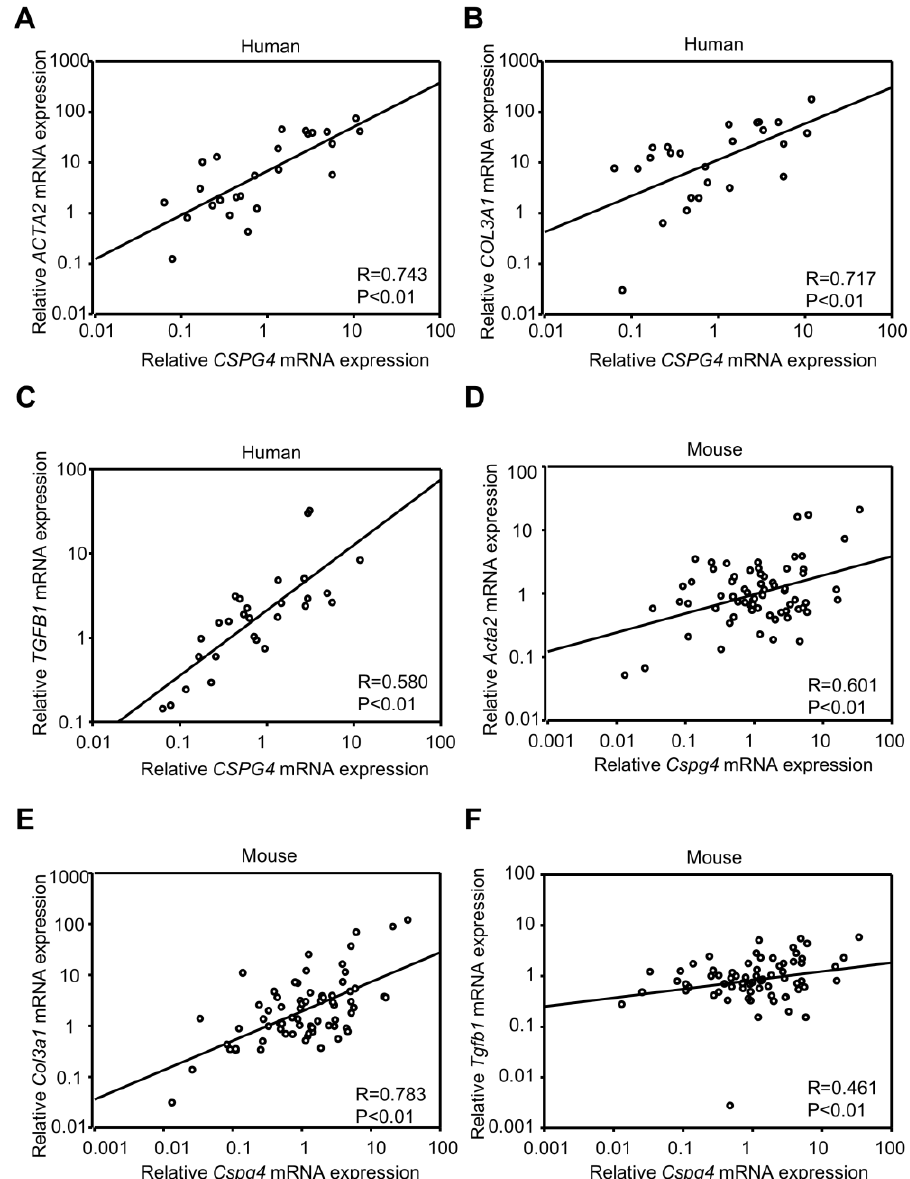
Figure 2. The positive correlation between CSPG4 and fibrosis markers in human and mouse liver. The correlation between the hepatic mRNA levels of Cspg4 and fibrotic parameters, including Acta2 ( A ), Col3a1 ( B ) and Tgfb1 ( C ) in mouse liver. n = 69. The correlation between the hepatic mRNA levels of CSPG4 and ACTA2 ( D ), COL3A1 ( E ) and TGFB1 ( F ) in human liver. n = 28.